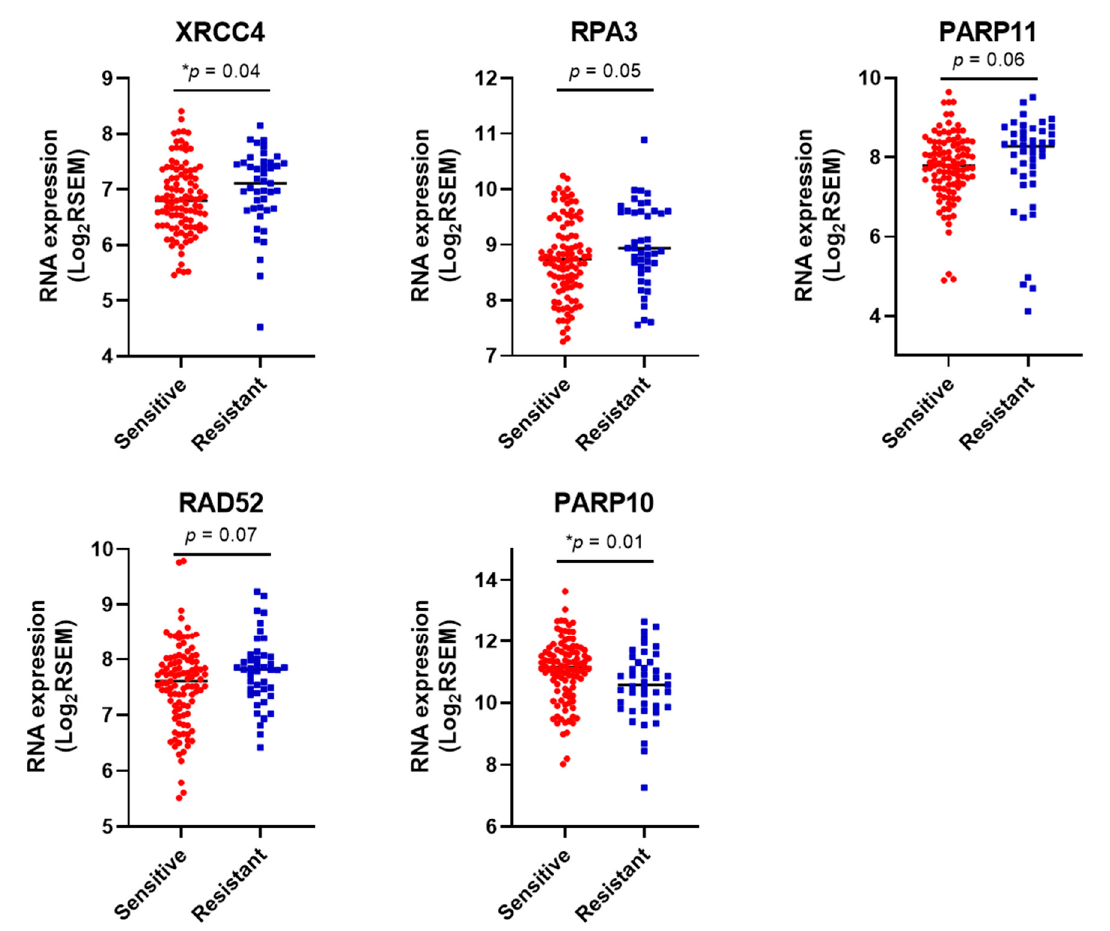
Figure 4. Differential expression of five out of 50 DDR genes between Platinum-sensitive and resistant ovarian cancers in the The Cancer Genome Atlas (TCGA) dataset ( n = 148). Fifty genes correlating with chemotherapy response identified through the clustering analysis were analysed for differential expression between the Platinum sensitive ( n = 105) and resistant ( n = 43) sub-groups of ovarian cancers in the TCGA dataset. The expression profile of five genes most differentially expressed between the two sub-groups is shown here. The log2RSEM values for each gene are plotted on the y -axis (* p < 0.05). Data for RAD51B and RAD51D unavailable.